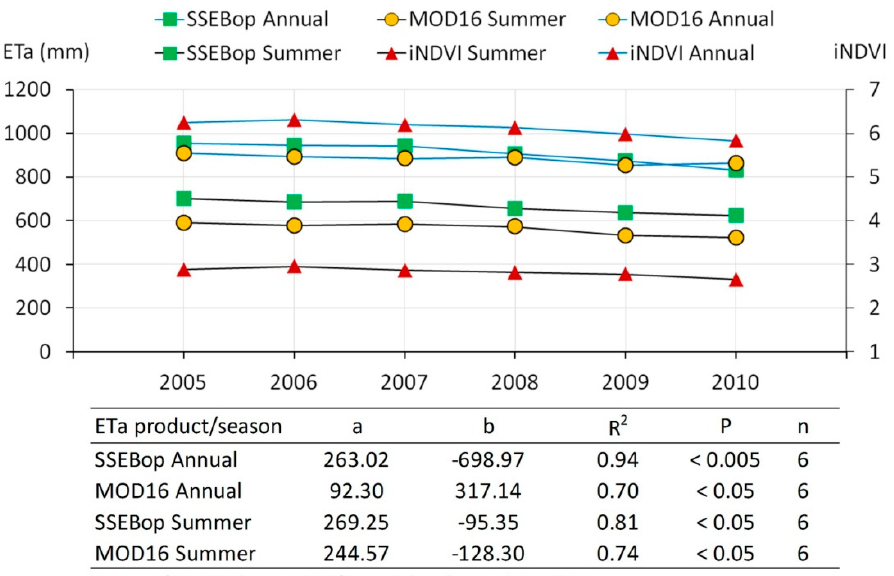
Figure 5. Correlation between the ETa and the iNDVI on a seasonal and annual basis from 2005 to 2010.